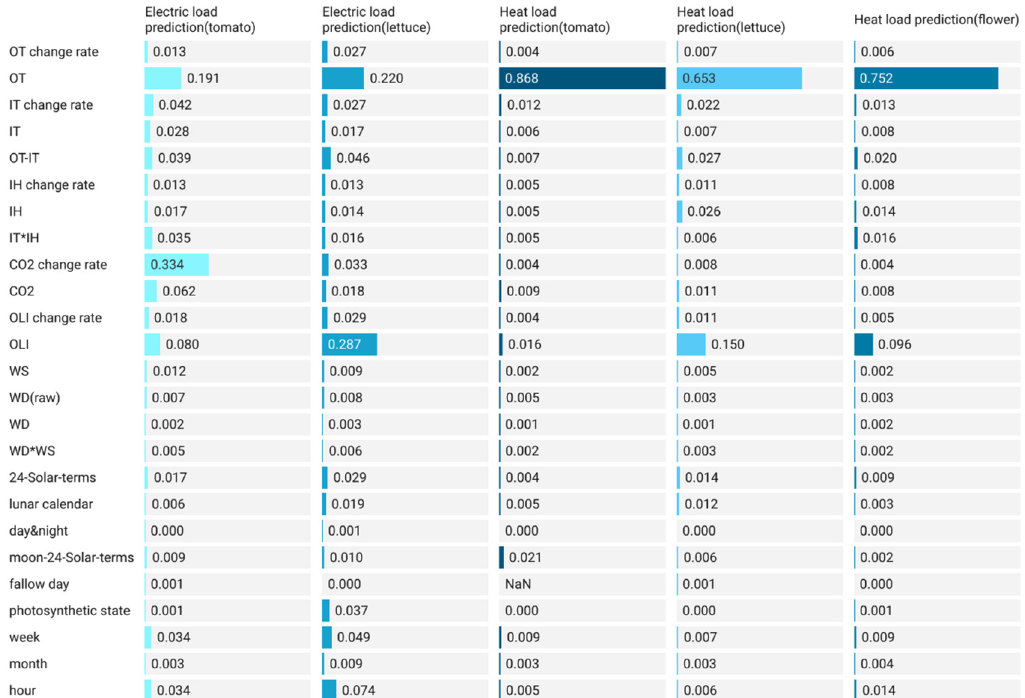
Figure 8. The importance of features (using